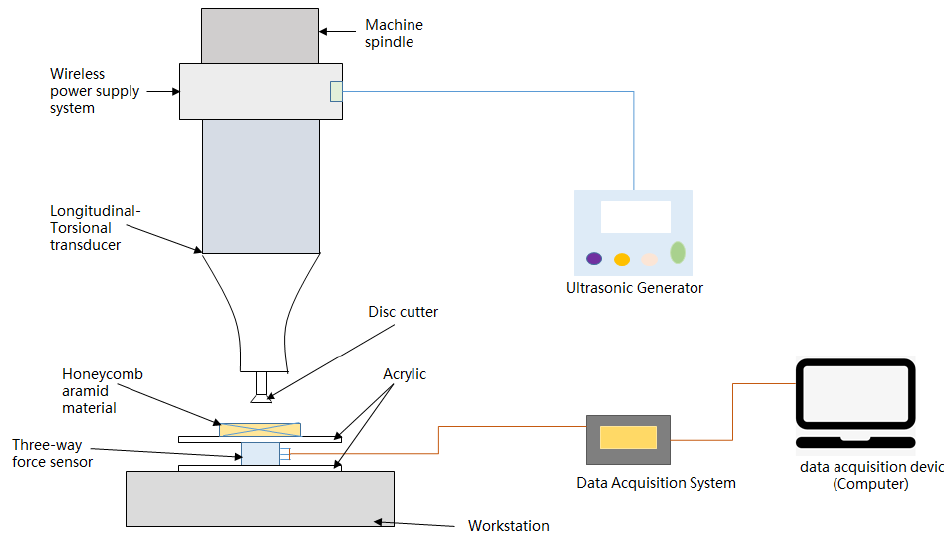
Figure 13. Schematic diagram of the cutting force system.